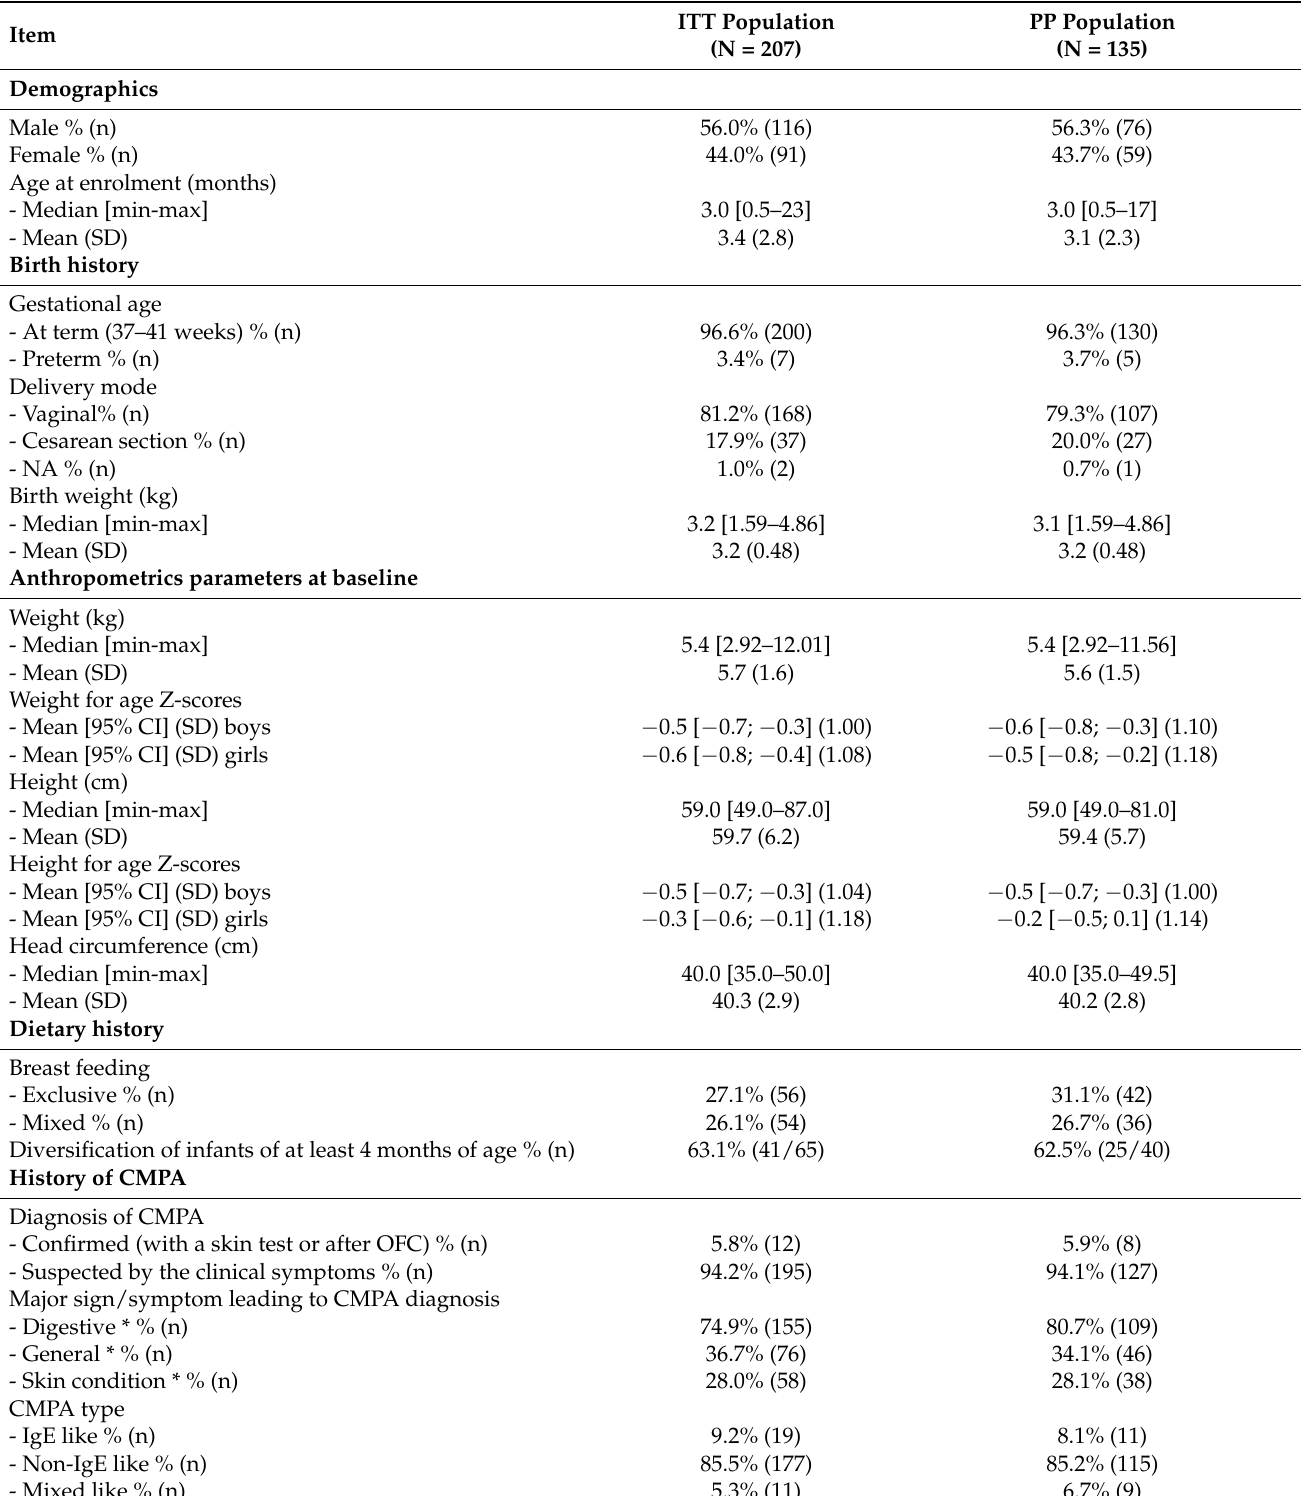
Table 1. Characteristics of infants at baseline in the ITT and PP